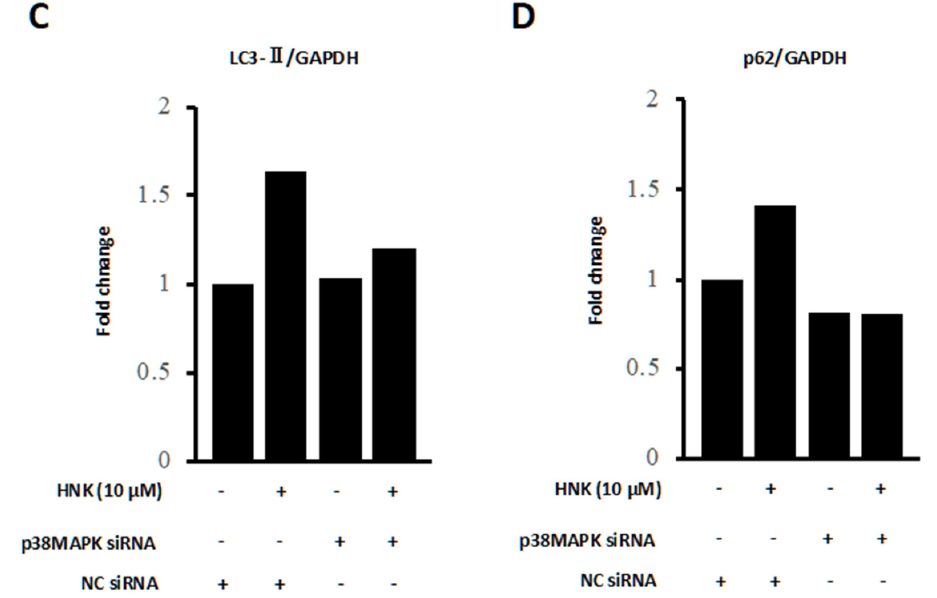
Figure 6. Assessment of the effect of HNK on signaling cascades associated with autophagy inhibition in HSC. ( A ) Immunoblot analysis of mTOR signaling and MAPK signaling in LX-2 cells 24 h after incubation in the presence of HNK at the noted concentrations for 24 h, with or without 10 μ M CQ treatment. ( B ) Immunoblot analysis was performed to detect levels of p-p38 MAPK, t-p38 MAPK, LC3, and p62 in LX-2 cells transfected with p38 MAPK or negative control (NC) siRNA and further treated with HNK for 24 h. ( C , D ) To compare ratios of LC3-II or p62 to GAPDH across samples, the fold change was calculated by dividing the normalized expression from each lane by the normalized expression of the control sample (HNK 0, with NC siRNA). Numbers on the right indicate the noted molecular weights (kDa). Phosphorylated S6K (p-S6K); total S6K (t-S6K); phosphorylated S6 (p-S6); total S6 (t-S6); phosphorylated ERK (p-ERK); total ERK (t-ERK); phosphorylated p38 (p38); total p38 (t-p38).